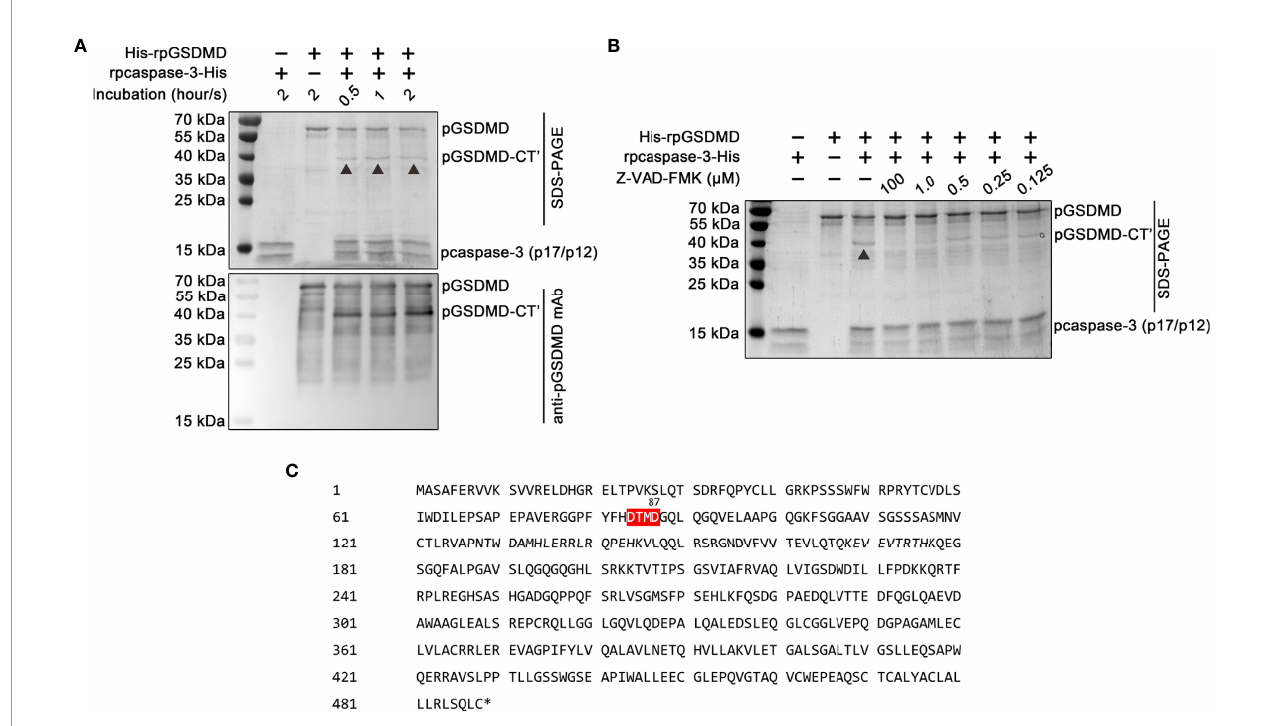
FIGURE 8 | Cleavage of His-rpGSDMD by rpcaspase-3-His. (A) Puri fi ed His-rpGSDMD was incubated with puri fi ed rpcaspase-3-His for 0.5, 1 and 2 h. The cleavage products of His-rpGSDMD were analyzed by SDS-PAGE and western blot assay. (B) The effect of Z-DEVD-FMK on rpcaspase-3-His mediated His- rpGSDMD cleavage. (C) The diagram of deduced cleavage site of pcaspase-3 in